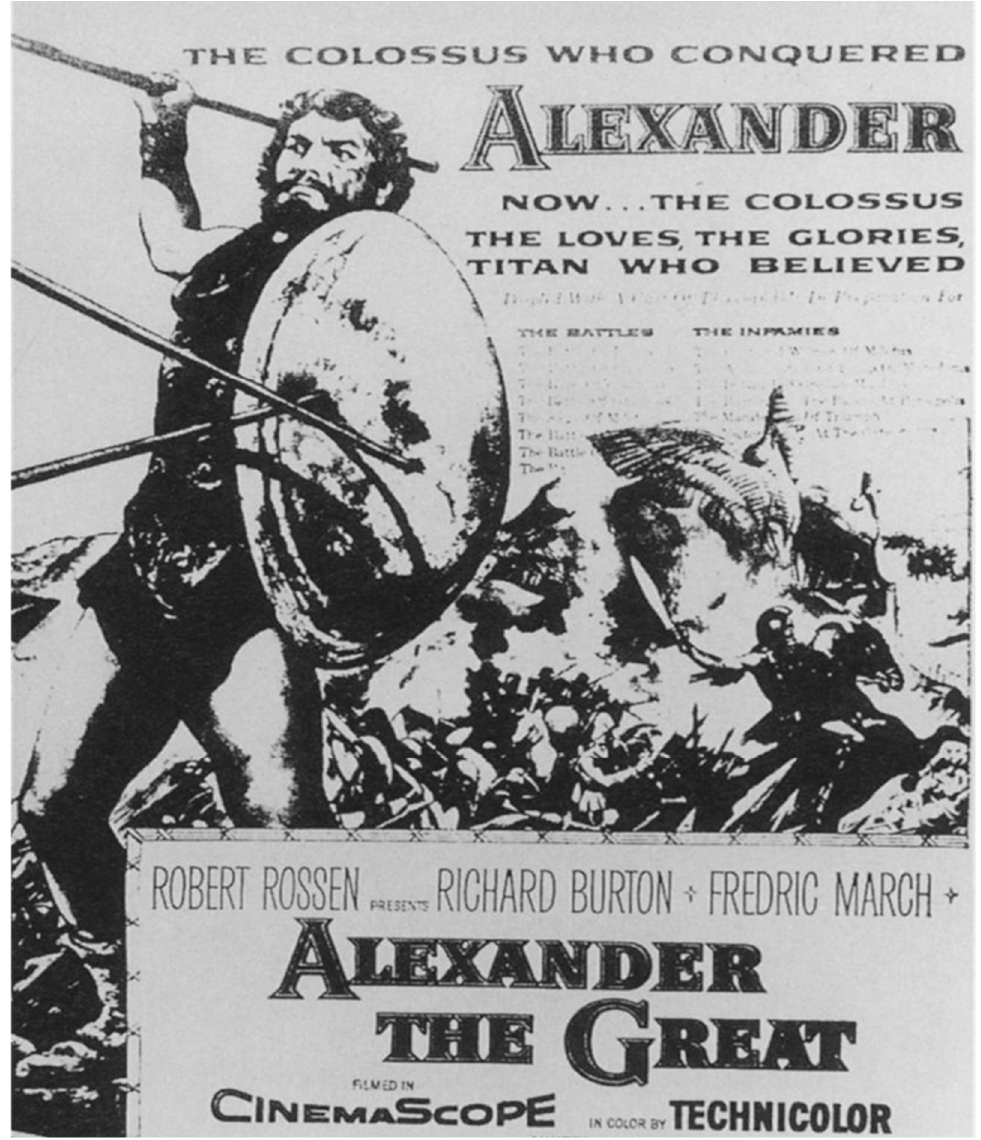
Figure 4. Advertisement for “Alexander the Great”, New York Journal-American, 28 March 1956, p. 22.